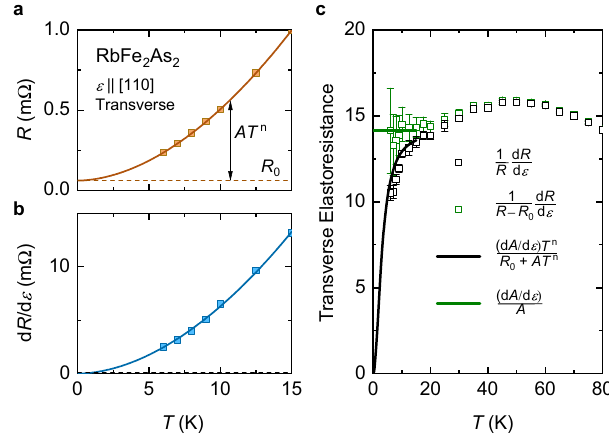
Fig. 4 Rede fi nition of of elastoresistance based on the temperature- dependent resistance contribution. a The resistance of a particular RbFe 2 As 2 crystal at temperatures where elastoresistance was measured. The solid line is a fi t of these points to R = R 0 + AT n (here n = 1.84). The dashed line represents the residual resistance R 0 . b The strain derivative of the sample resistance at selected temperatures. The solid line is a fi t of these points to d R /d ϵ = B + CT n (again n = 1.84). B is consistent with zero within uncertainty. The dashed line gives an upper limit on B , from the fi t uncertainty. c Elastoresistance calculated as m = (1/ R )d R /d ϵ (black) and (cid:1) the uncertainty in the estimation of R 0 . The solid lines show the same quantities instead calculated from the fi tted functions in ( a , b